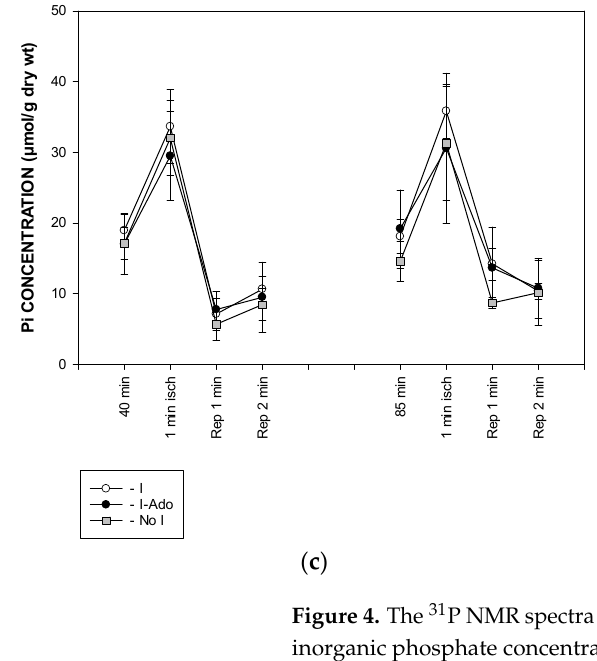
Figure 4. The 31 P NMR spectra based calculation of ( a ) ATP, ( b ) phosphocreatine, and ( c ) intracellular inorganic phosphate concentrations before, during, and after 1 min ischemia in hearts subjected to 1 min ischemia at 40 min of perfusion, 10 min ischemia at 50 min of perfusion, and 1 min ischemia at 85 min of perfusion without (Group I) or with (Group I-Ado) supply of adenosine at 30 µM concentration during the first 15 min of reperfusion and in control hearts (Group No I) subjected three times to 1 min ischemia at 40, 50, and 85 min of perfusion. For the initial values, control hearts (Group C) were perfused for 20 min. Values are mean ± SEM ( n = 5–9).